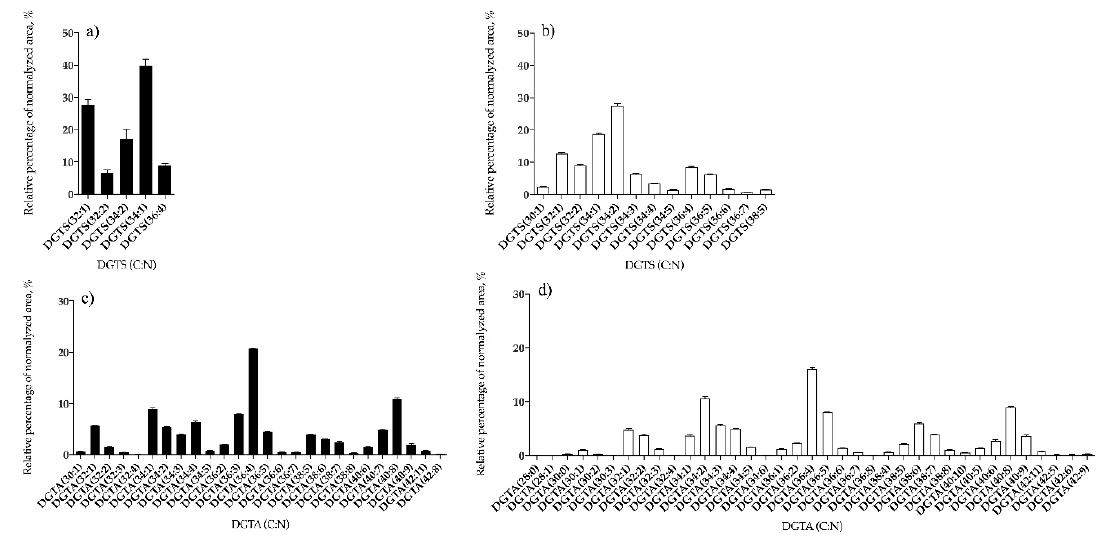
Figure 4. Relative abundance (RA) of betaine lipid species identified as diacylglyceroltrimethylhomoserine (DGTS) ( a ) and diacylglyceroltrimethyl- β -alanine (DGTA) ( c ) in B. bifurcata , and DGTS ( b ) and DGTA ( d ) in S. muticum . The results are expressed as relative percentage after dividing the normalized peak area of each lipid species to the sum of normalized peak areas for all the lipid species within the class obtained after LC–MS analysis. Numbers in parentheses (C:N) indicate the number of carbon atoms (C) and double bounds (N) in the fatty acid side chains. The species with higher RA were DGTS (34:1) and DGTA (36:4) for B. bifurcata and DGTS (34:2) and DGTA (36:4) for S. muticum . Phospholipid classes identified in B. bifurcata and S. muticum included phosphatidylcholine